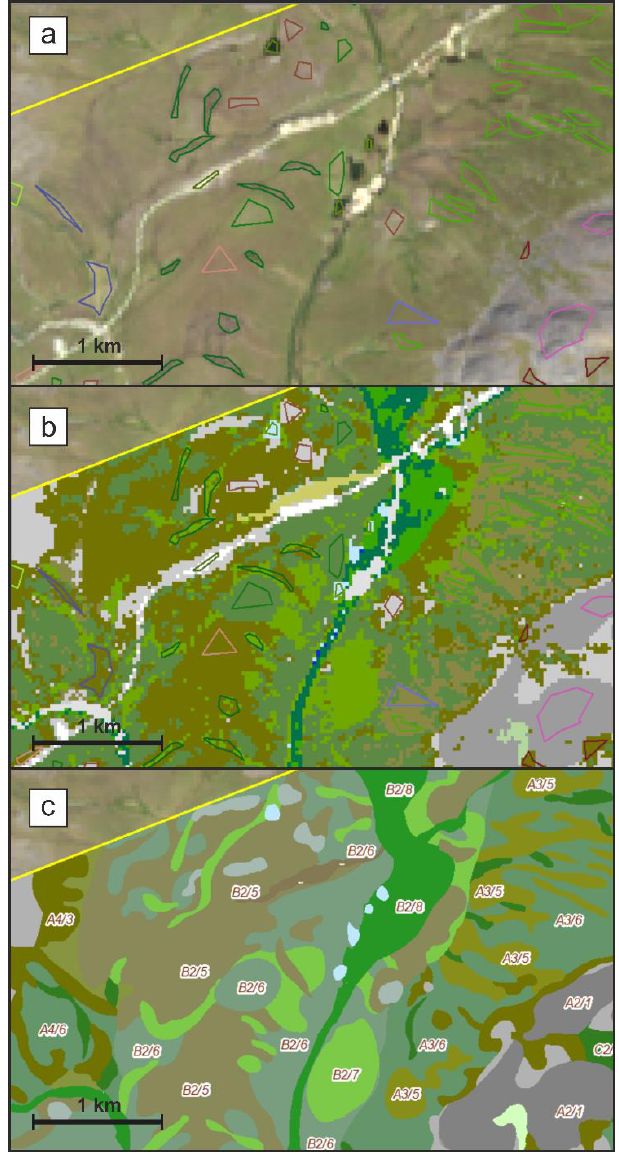
Figure 2. Stages of drawing up the landscape map: ( a ) identifying standards (key plots) on a satellite image; ( b ) conducting a controlled classification of covers; ( c ) generalizing of landscape contours. The legend is given in Table S1.